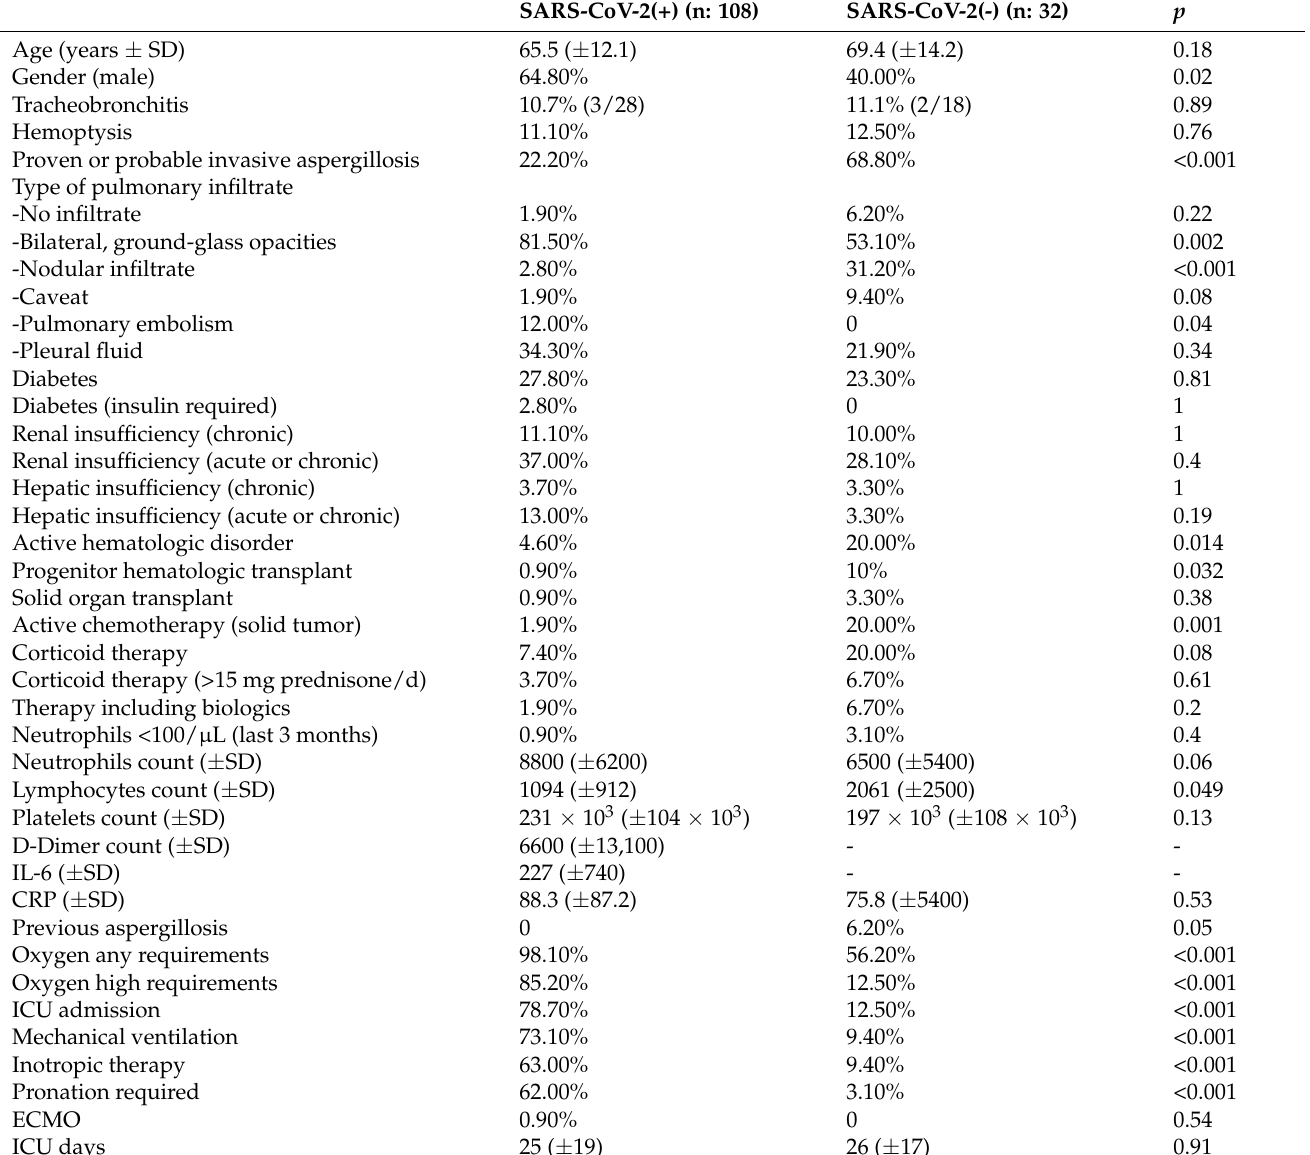
Table 3. Baseline characteristics of patients with IPA (proven, probable, or